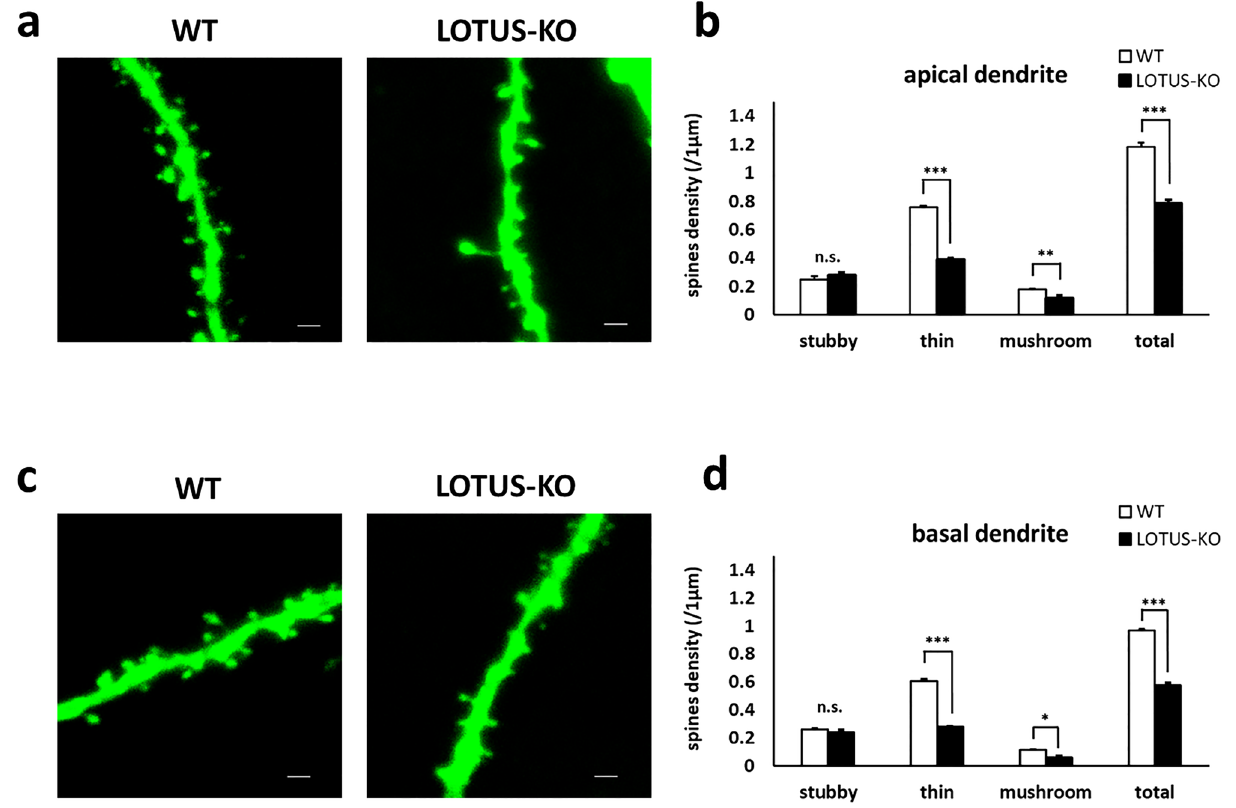
Figure 3. Loss of LOTUS decreases spine density in the hippocampal CA1 region. ( a ) LOTUS controls the dendritic spine in apical dendrites. Scale bars, 1 µm. ( b ) Quantification of the spine density in apical dendrites of hippocampal neurons in the CA1 region; 41 − 43 dendrites were analyzed in each mouse (WT: n = 3; LOTUS-KO: n = 3). Data are means ± SEM from ** P < 0.01, *** P < 0.001. Student’s unpaired t -test. ( c ) LOTUS controls the dendritic spine in basal dendrites. Scale bars, 1 µm. ( d ) Quantification of the spine density in basal dendrites of hippocampal neurons in the CA1 region; 40 − 44 dendrites were analyzed in each mouse (WT: n = 3; LOTUS-KO: n = 3). Data are means ± SEM from * P < 0.05, *** P < 0.001, Student’s unpaired t -test.